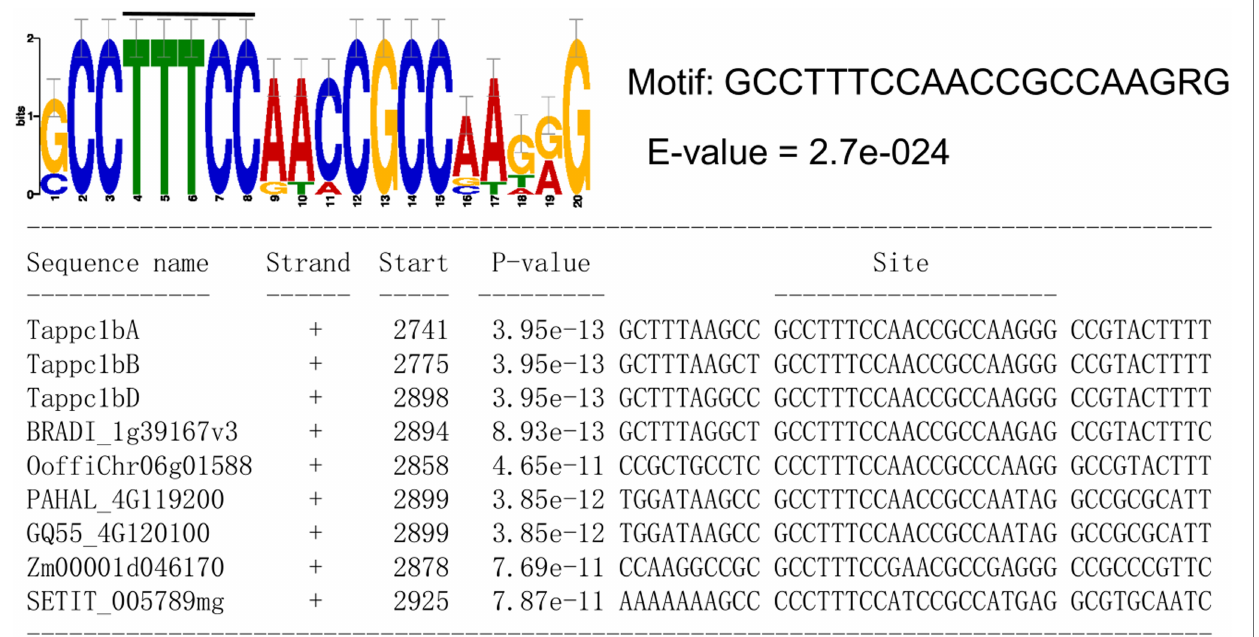
FIGURE 10 | A predicted cis-motif associated with the nitrate responses of Tappc1b isogenes. The black bar above the motif logo represents the position of Dof1 binding core